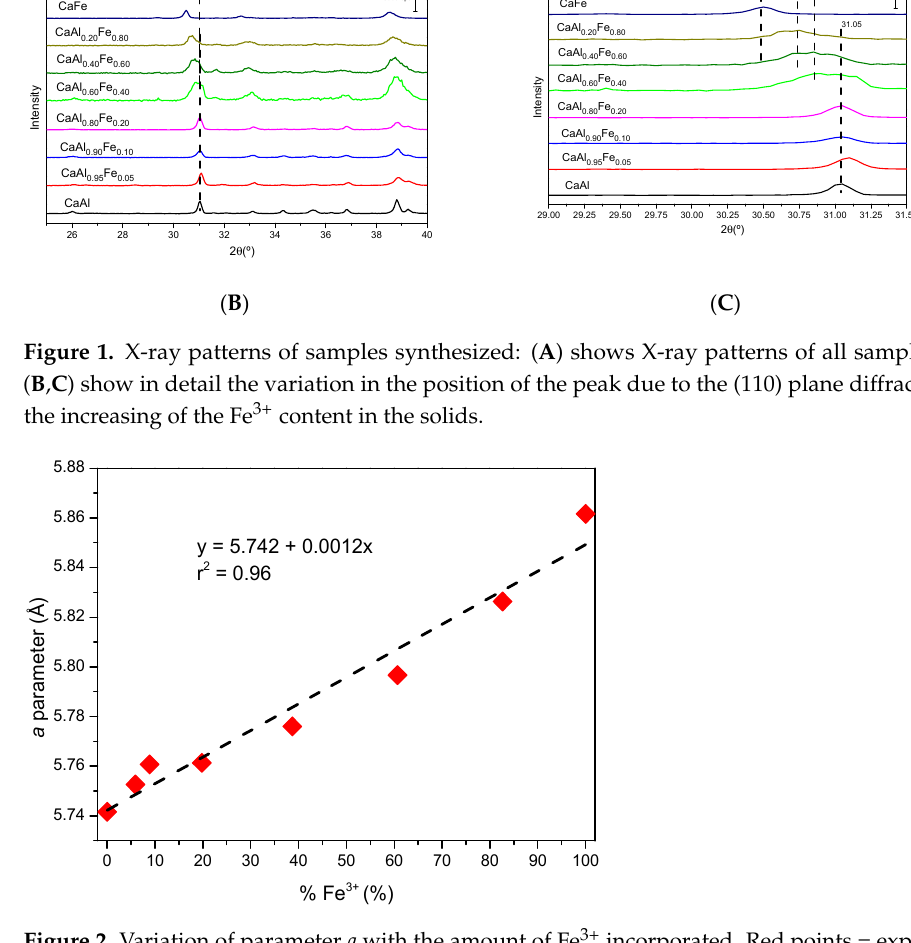
Figure 2. Variation of parameter a with the amount of Fe 3+ incorporated. Red points = experimental values; Dashed line: straight adjustment.